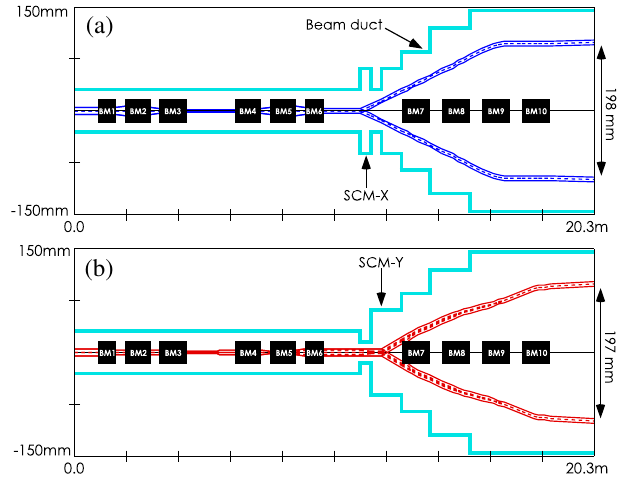
FIG. 5. (a) Horizontal and (b) vertical beam envelope func- tions with kicks of the scanning magnets, SCM-X and SCM-Y. The maximum kick angles of (cid:1) 18 and (cid:1) 21 mrad for beams having 430 MeV =u were applied for SCM-X and SCM-Y, respectively. In the calculations, typical values of matched emittances, " H ¼ " V ¼ 2 (cid:5) mm mrad , and momentum spread, (cid:1) p=p ¼ (cid:1) 5 (cid:3) 10 (cid:2) 4 , for beams having 430 MeV =u were as-